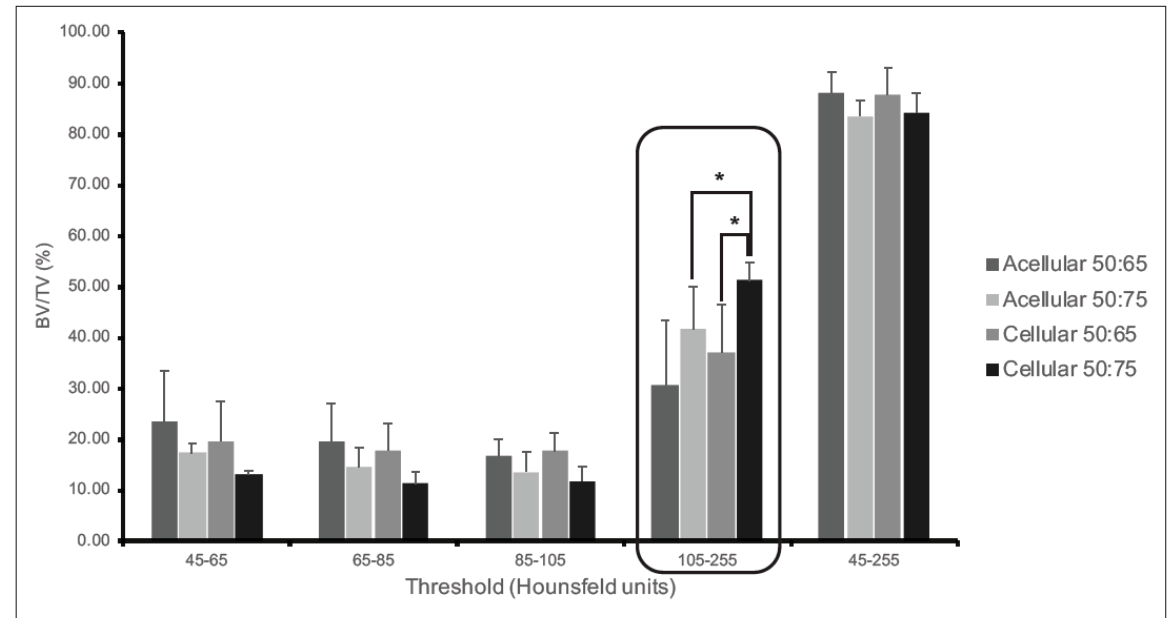
Figure 5. MicroCT data analysis. Graphical representation of percent bone volume/total volume (%BV/TV) from the microCT scans of all the rat femurs. Data is reported as a function of individua threshold Hounsfeld units. As described in the Section 3 these data are significant in the 105–255 unit range, which denotes 50% new bone and, which is closely matched to that of the phantom. Asterisks denote significant increase in the %BV/TV in rats treated with 50:75 + MSCs compared to those treated with 50:75 alone. Similarly, there is a significant increase in %BV/TV in rats treated with 50:75 + MSCs compared to those treated with 50:65 + MSCS.